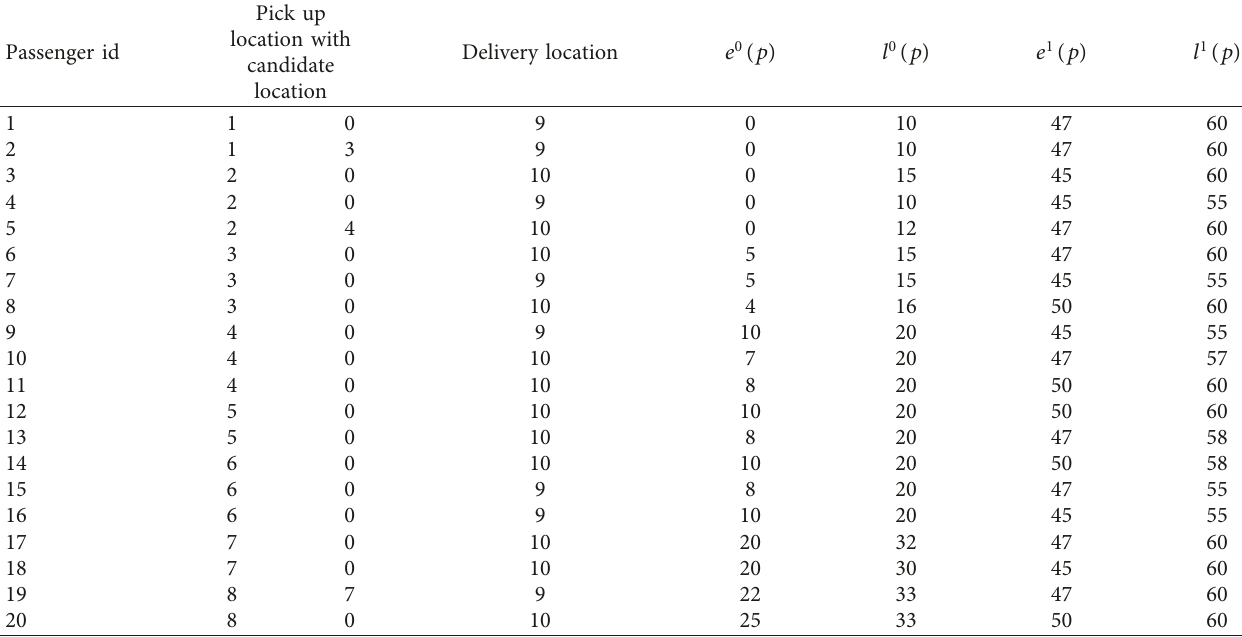
Figure 6: The distribution of candidate locations. Red and green, respectively, represent the pickup and delivery locations of passengers. (a) Destination: Jinrongjie and (b) Destinantion: Guomao. Table 12: Passenger demands information of Group 1.